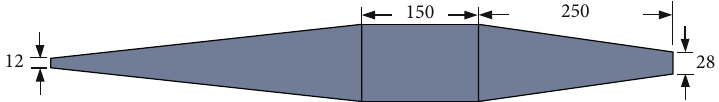
Figure 3: Schematic diagram of a special-shaped bullet (unit:mm).